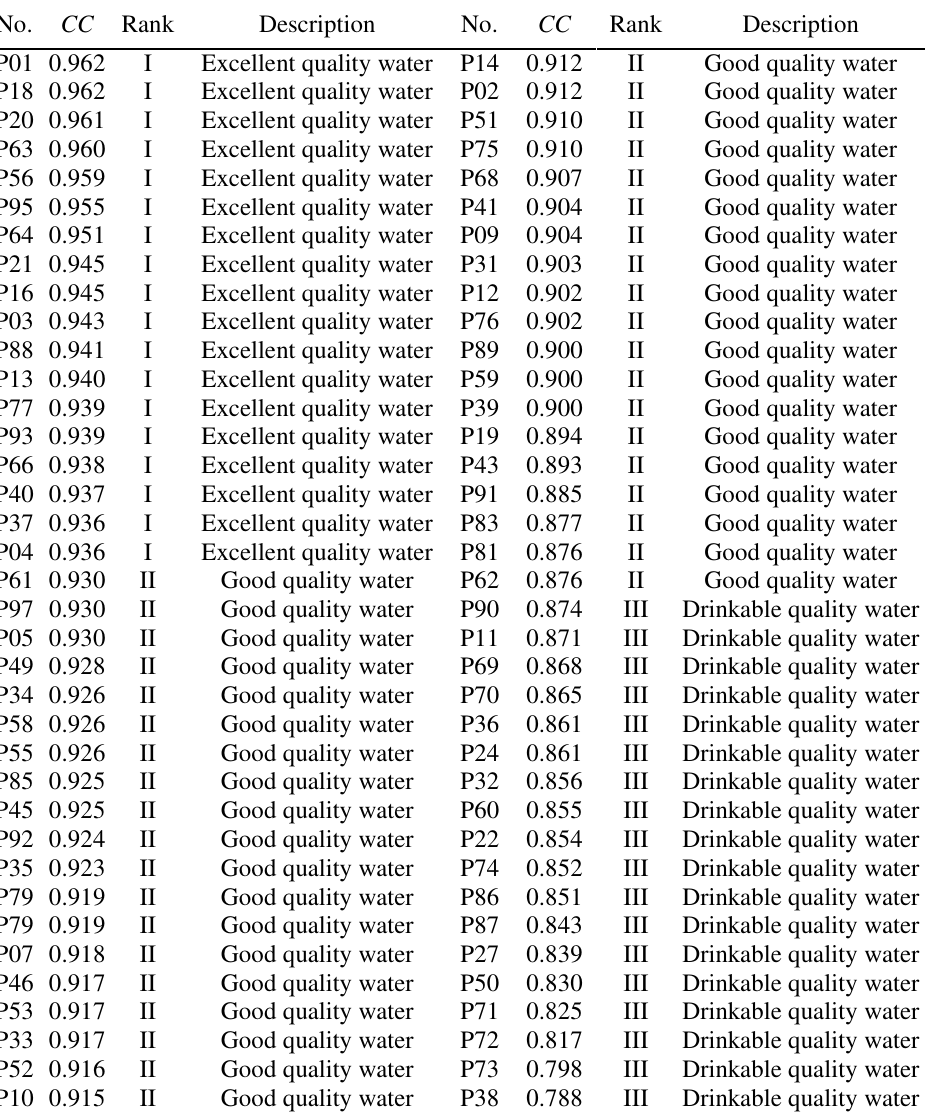
Table 4. Groundwater quality assessment results based on entropy weighted TOPSIS